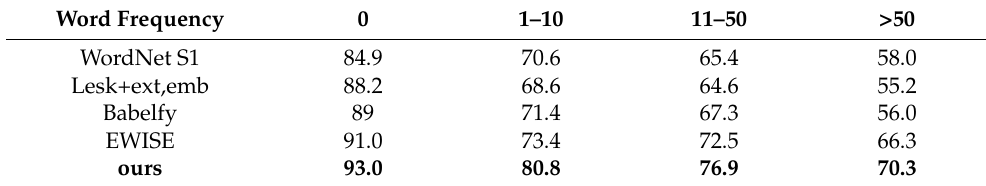
Table 3. F1-score (%) on words with different frequencies in the training corpus. Word